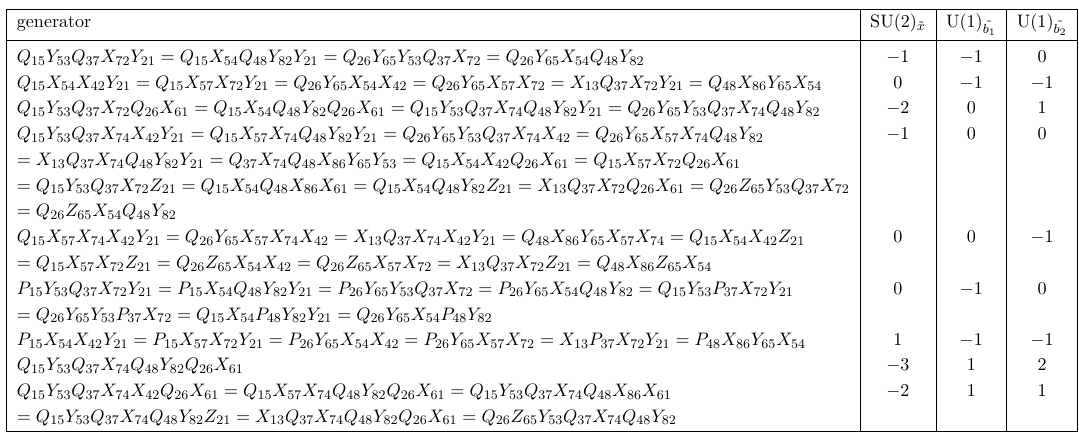
Table 41 . The generators in terms of bifundamental chiral fields for Model 10 (Part 1) .